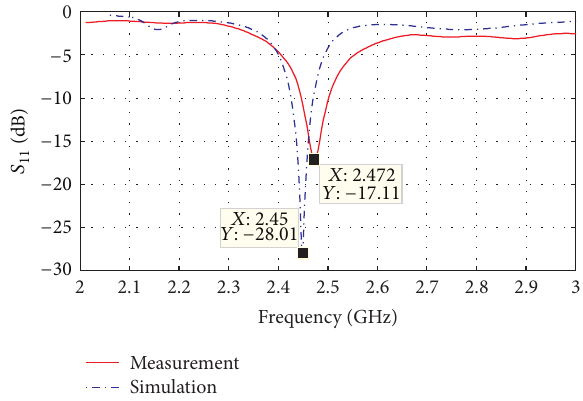
Figure 10: Simulated and measured return